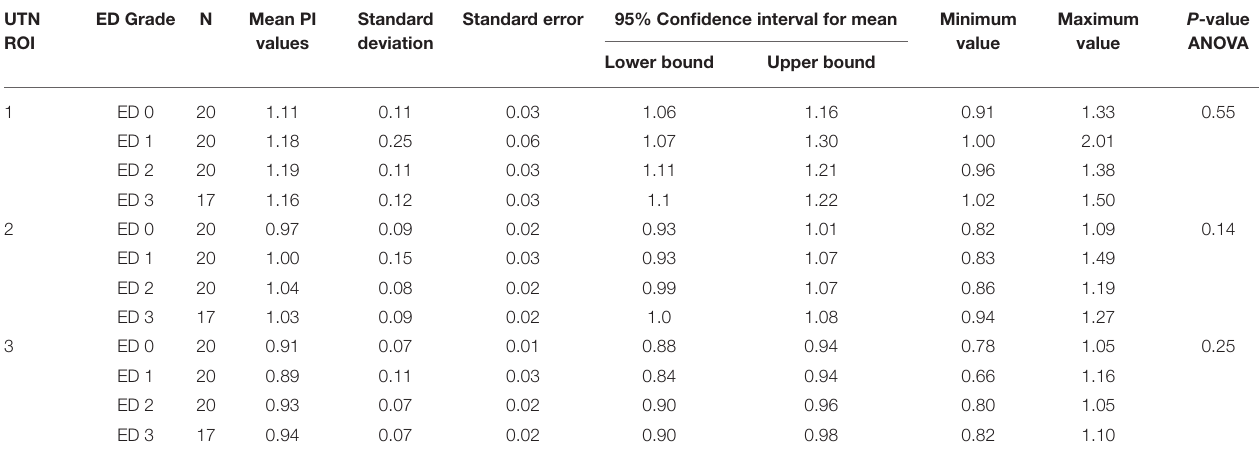
TABLE 1 | Normalized mean pixel intensity (PI) values in the different ulnar trochlear notch (UTN) regions of interest (ROIs) for the right-side elbow joints classified with different elbow dysplasia (ED) grades. UTN ROI